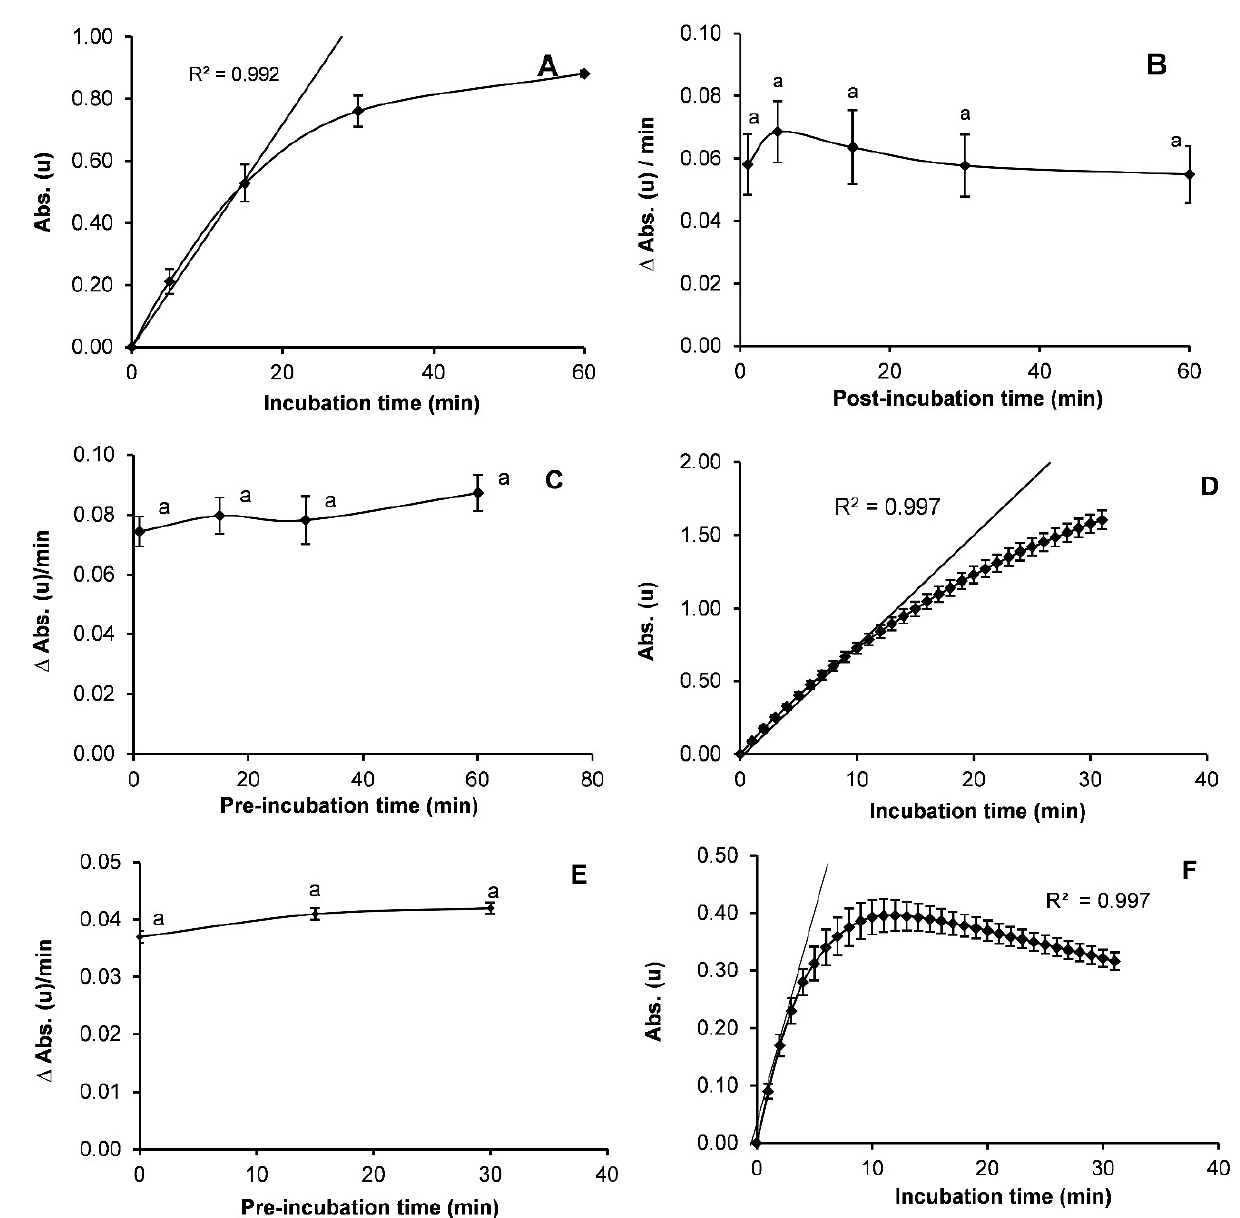
Figure 5. Influence of pre-incubation, incubation and post-incubation times on absorbance or absorbance rate (ΔAbs.(u)/min) with α-naphthyl acetate ( A , B ), CDNB ( C , D ) and cytochrome C ( E , F ) substrates. The error bars correspond to standard error (Total number of insects tested, ( A ) n = 8, ( B ) n = 20, ( C ) n = 32, ( D ) n = 20, ( E ) n = 6 and ( F ) n = 16). Absorbance rate values with different letters ( B , C and E ) are significantly different according to mean separation using Tukey-Kramer’s test ( p < 0.05).